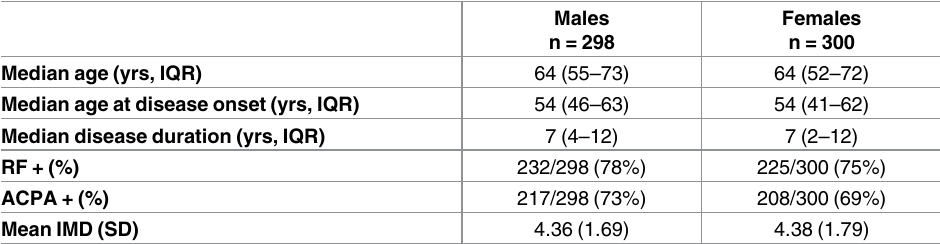
Table 1. Cohort 1 demographic